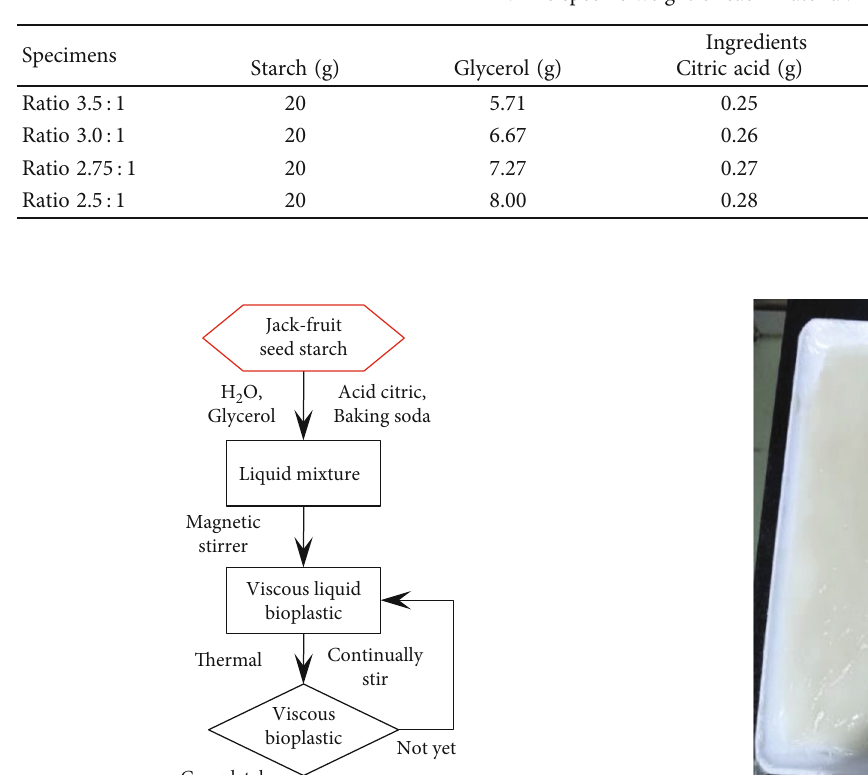
Figure 2: Flattened viscous bioplastic on the PE fi lm coated tray.